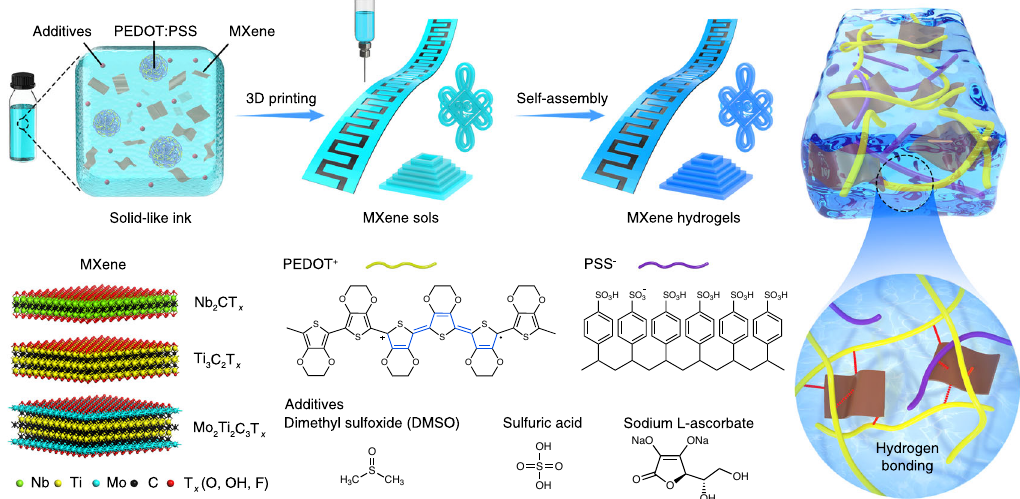
Fig.1|Schematicillustrationof4DprintingofMXenehydrogels. Thecomposite inksconsistingofMXenes,PEDOT:PSS,andadditives(DMSO,H 2 SO 4